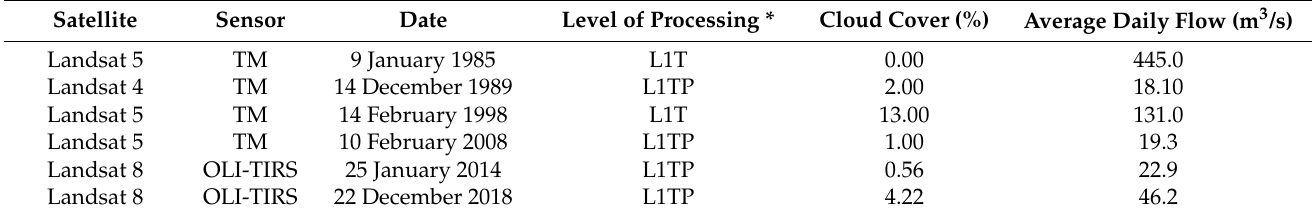
Table 2. Characteristics of the selected multispectral Landsat